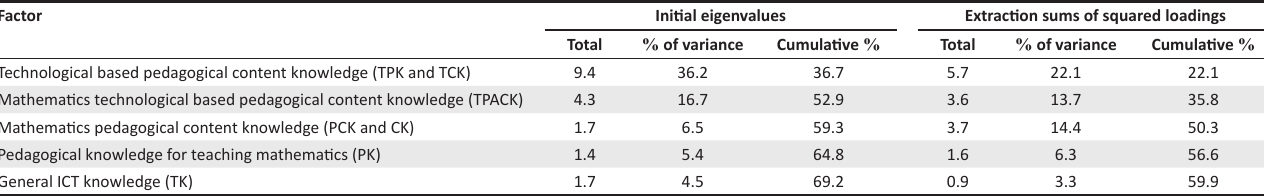
TABLE 3: Exploratory factor analysis results. Factor